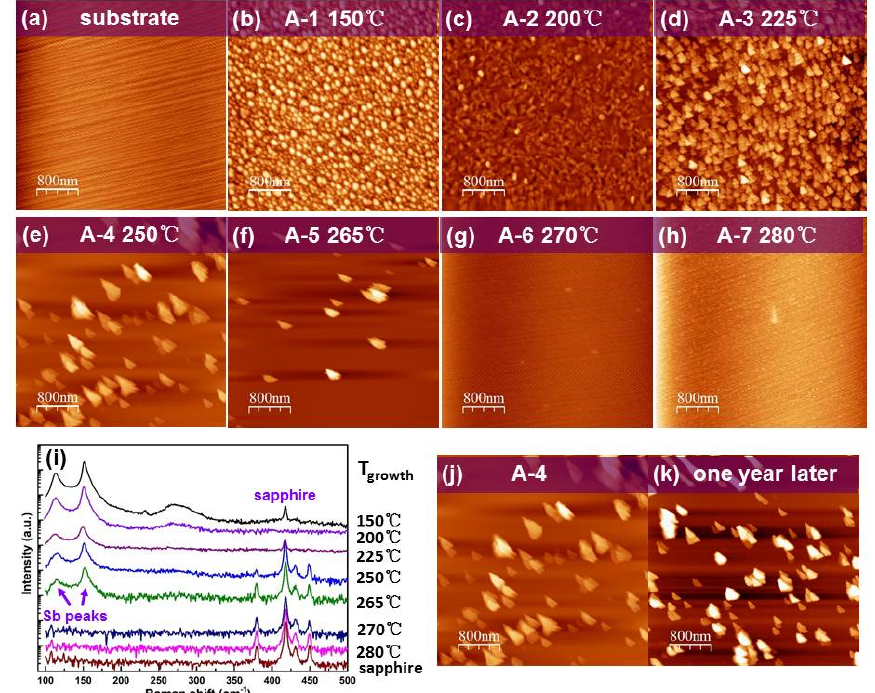
Figure 2. ( a – h ) AFM images of a c-plane sapphire substrate and sample A-1 to A-7, showing the surface morphology change due to the temperature increment. ( i ) Raman spectra of all the group A (Sb 4 ) samples. Peaks at 350 cm − 1 to 450 cm − 1 are from the c-plane sapphire, 110 cm − 1 and 150 cm − 1 are the two signature vibrational modes of antimony. ( j , k ) AFM images of antimonene, being characterized immediately after the sample is taken out of the vacuum and one year later.